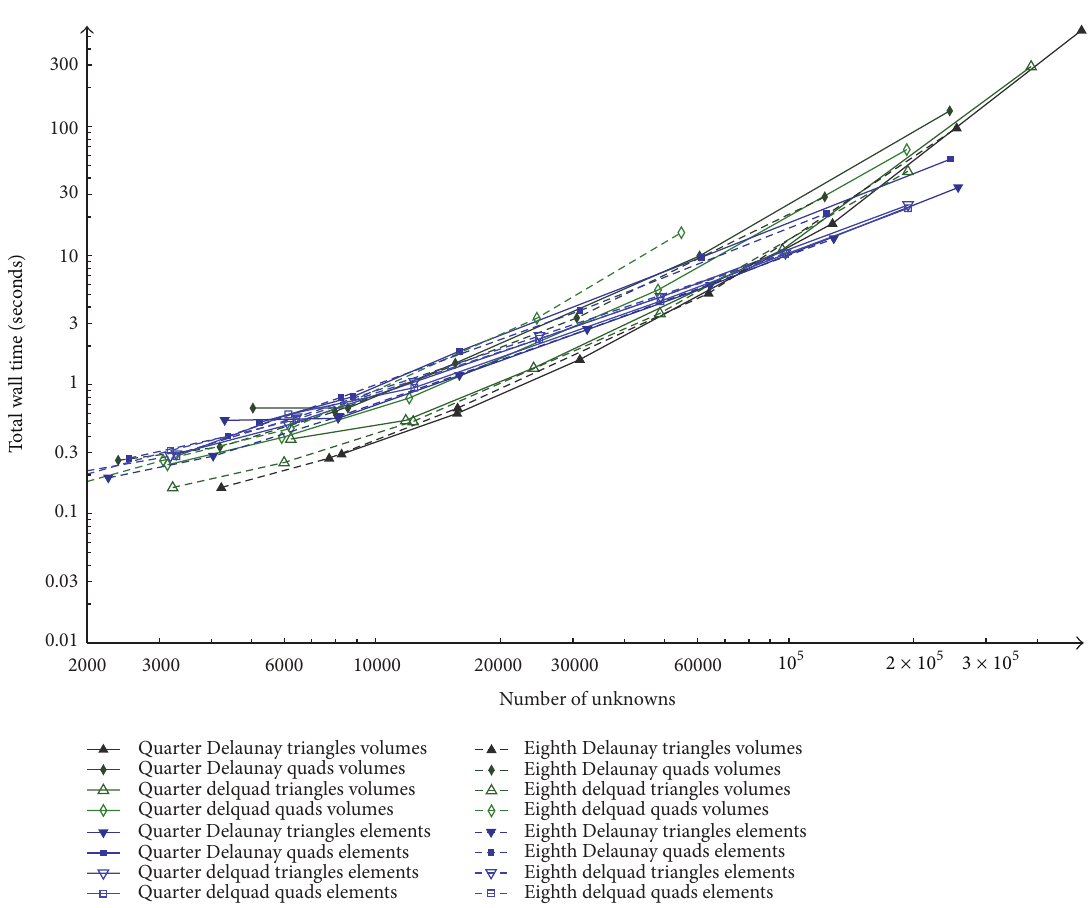
Figure 20: Total wall time versus number of